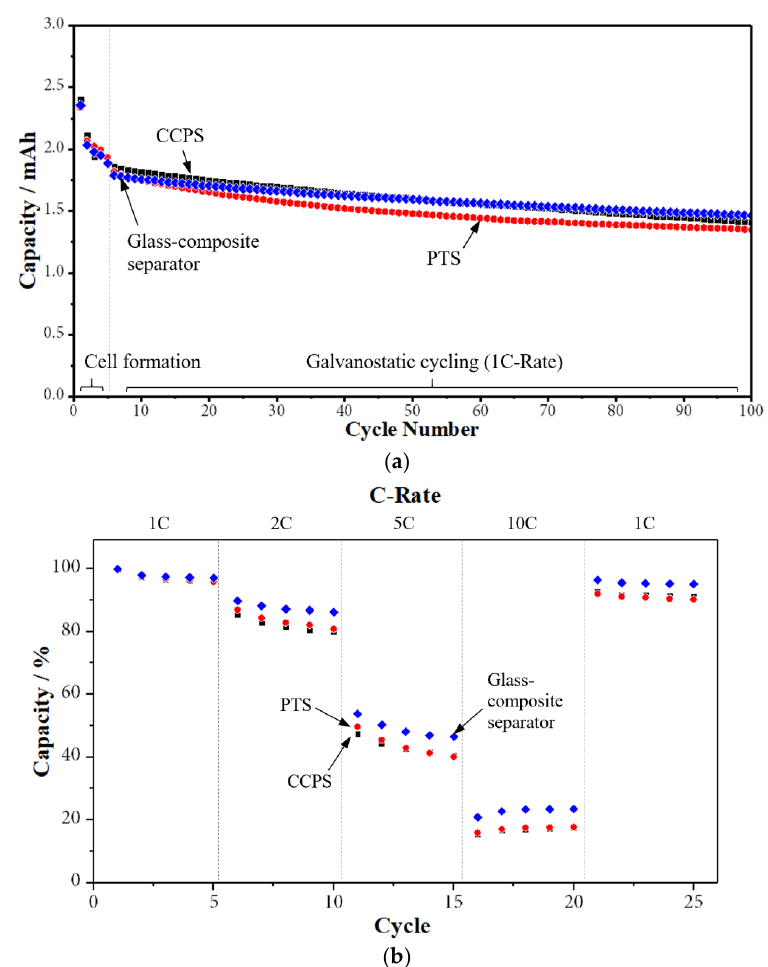
Figure 8. Battery performance of a glass composite separator, a PTS, and a CCPS in a graphite/LFP full-cell configuration ( a ) cell formation progressing cycling at 1 C-rate; ( b ) rate capability at a 1 C, 2 C, 5 C, and 10 C-rate after previous cycling at a 1 C-rate for 95 cycles and cell formation.